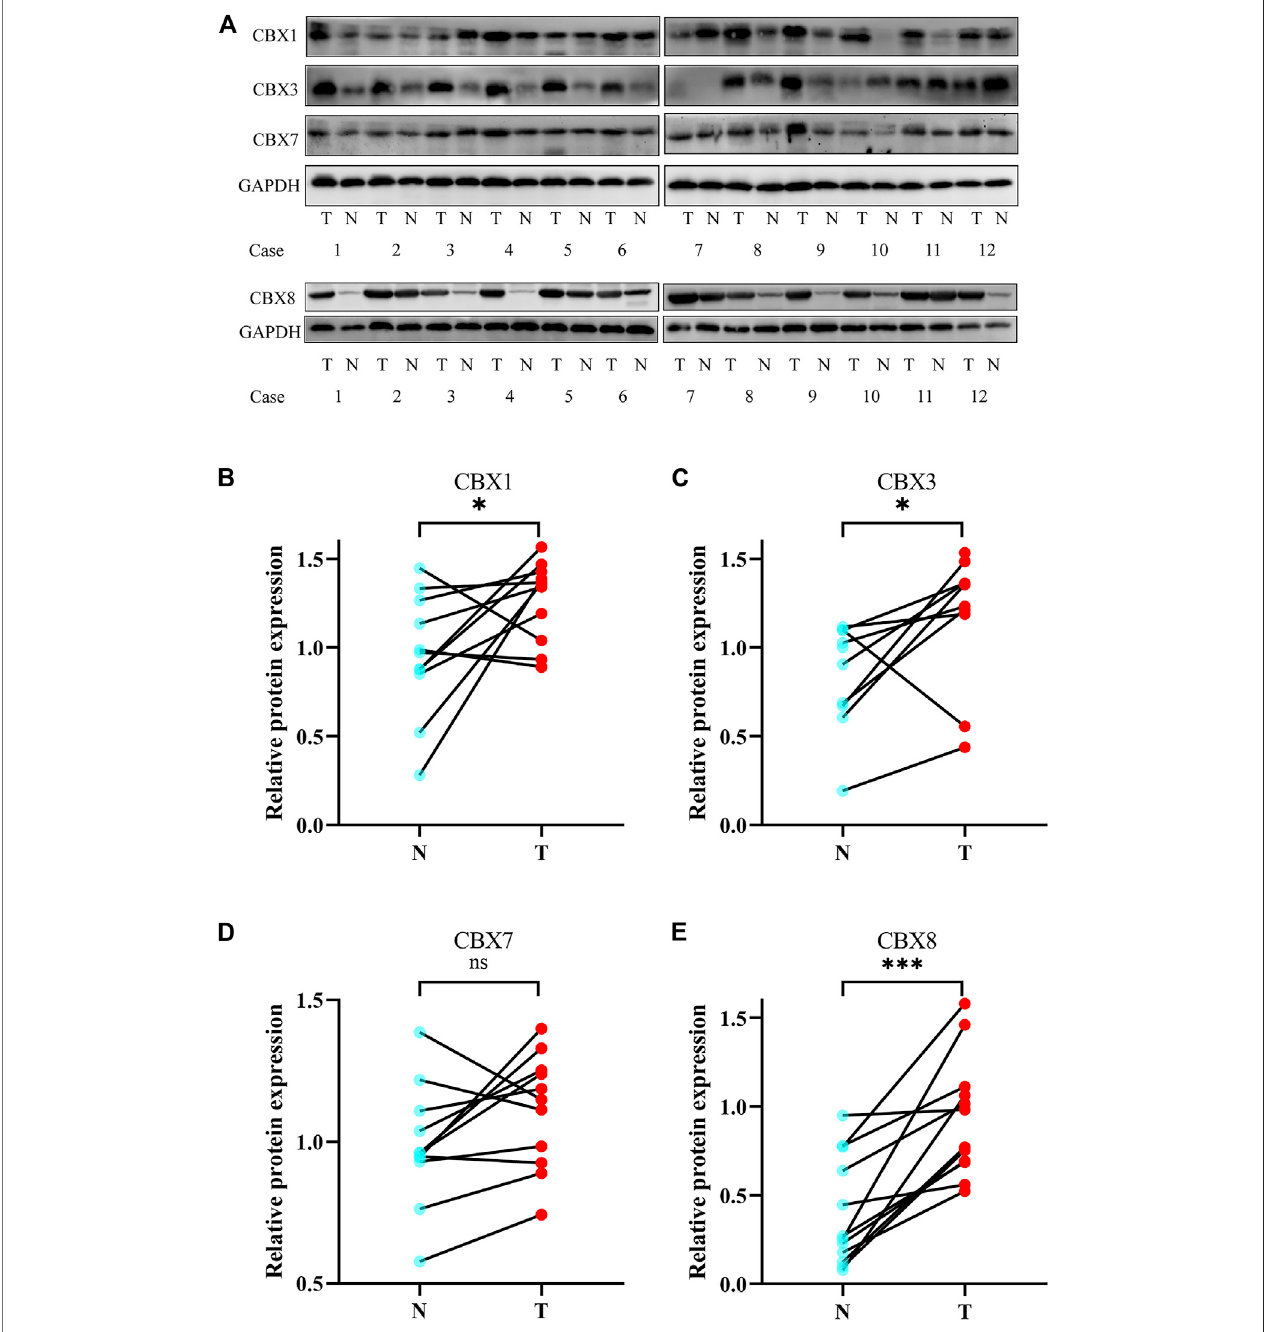
FIGURE9| ProteinexpressionlevelsofCBX1,CBX3,CBX7,andCBX8in12ESCAtissuesandadjacentnormaltissues(westernblot). (A) CBX1,CBX3,andCBX8 were upregulated in ESCA tissues compared with adjacent normal tissues, while CBX7 was expressed at similar levels in ESCA and normal esophageal tissues. (B – E) Statistical results of western blotting of CBX1, CBX3, CBX7, and CBX8 in ESCA tissues and normal tissues. (* p < 0.05, analysis by paired t-test.)